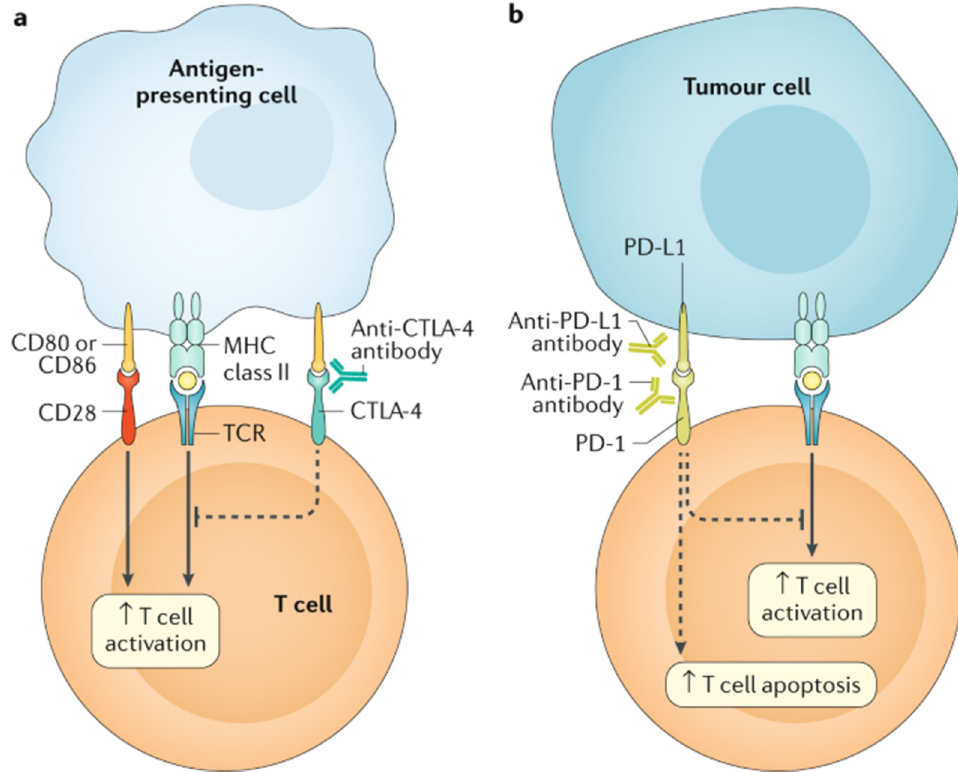
Figure 2. The main immunotherapy approaches that are approved for clinical use in cancer are the immune checkpoint inhibitors. These therapies are monoclonal antibodies that target the CTLA-4 and PD-1 receptors and the PD-1 ligand PD-L1, which are involved in the regulation of T cell activation. ( a ) T cell activation requires two signals: first, antigen recognition by the T cell receptor (TCR) following antigen presentation by major histocompatibility complex (MHC) class II molecules on the surface of antigen-presenting cells; and, second, signal modulation by CD80 or CD86 binding to the CD28 receptor. CTLA-4 is located on the T cell surface and competes with the CD28 receptor to bind CD80 or CD86, thereby blocking T cell activation. CTLA-4 inhibitors block CTLA-4–CD80 or CTLA-4–CD86 binding to facilitate T cell activation (dashed line). ( b ) PD-1 is a surface receptor that is expressed by T cells and promotes apoptosis of antigen-specific T cells and reduces apoptosis of regulatory T cells through its interaction with its ligand, PD-L1, which is expressed by tumour cells and myeloid cells. This interaction is useful in preventing autoimmunity in physiological conditions, but cancer cells exploit this process to escape from immune system activity upregulating PD-L1 expression. PD-1 and PD-L1 inhibitors block the PD-1–PD-L1 interaction, facilitating T cell activation and survival (dashed lines). (Figure with permission from Ramos-Casals M, Brahmer JR, et al. Immune-related adverse events of checkpoint inhibitors. Nat Rev Dis Primers. 2020 May